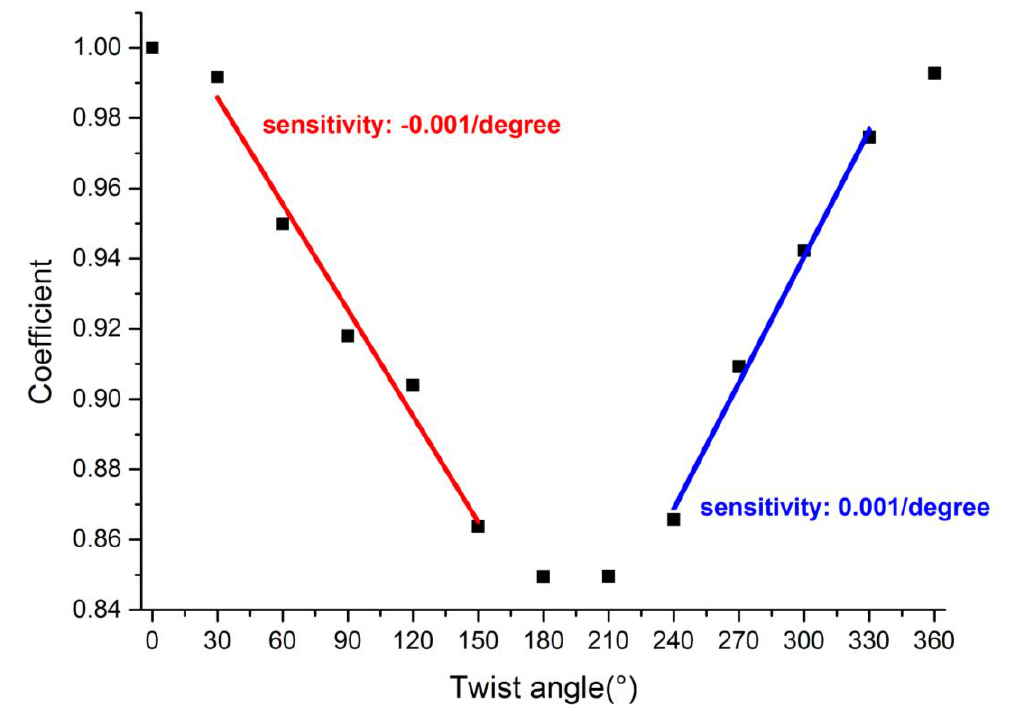
Figure 12. Correlation of spectra under different twist angles.